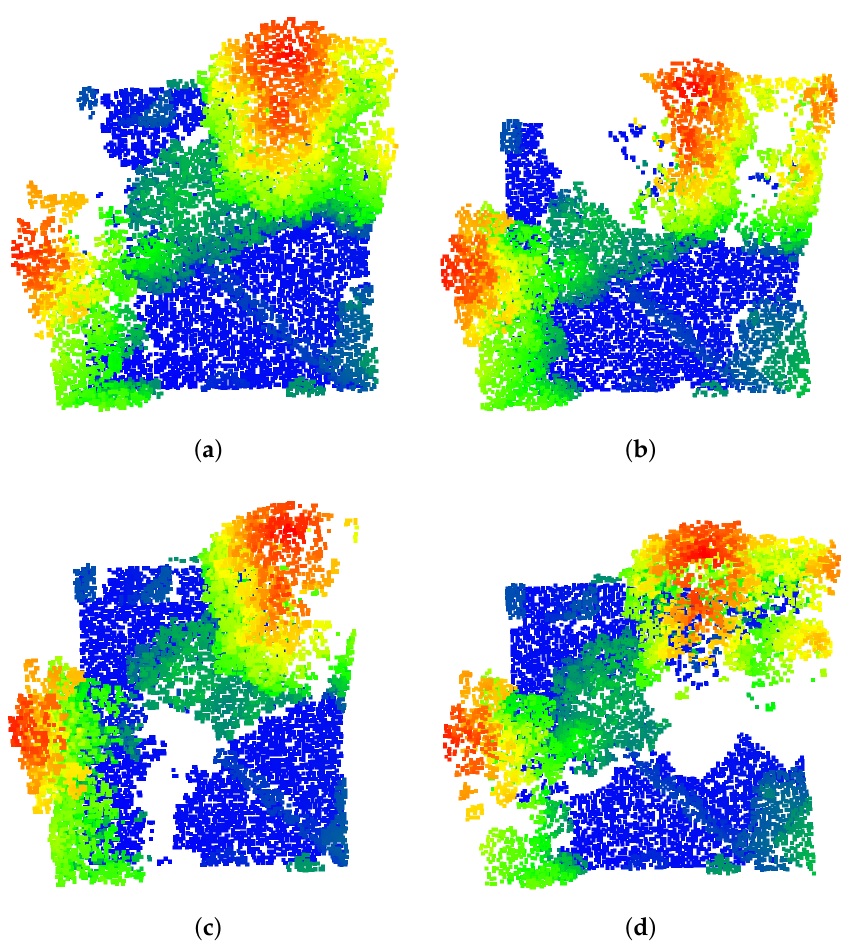
Figure 2. A single scene from DALES Viewpoints Version 2, colored by height, with occlusions from multiple flight patterns. ( a ) Northwest to Southwest, ( b ) Southwest to Southeast, ( c ) Southeast to Northwest, ( d ) Northeast to